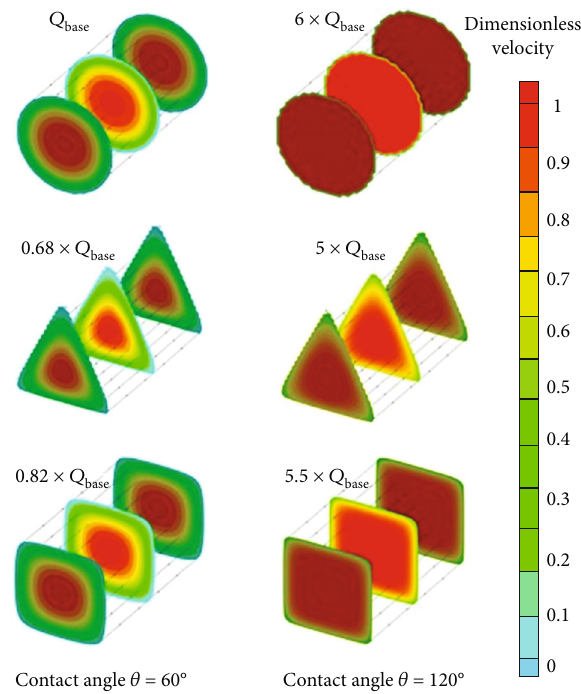
Figure 12: Dimensionless velocity pro fi le of di ff erent contact angles with di ff erent cross-sectional shapes